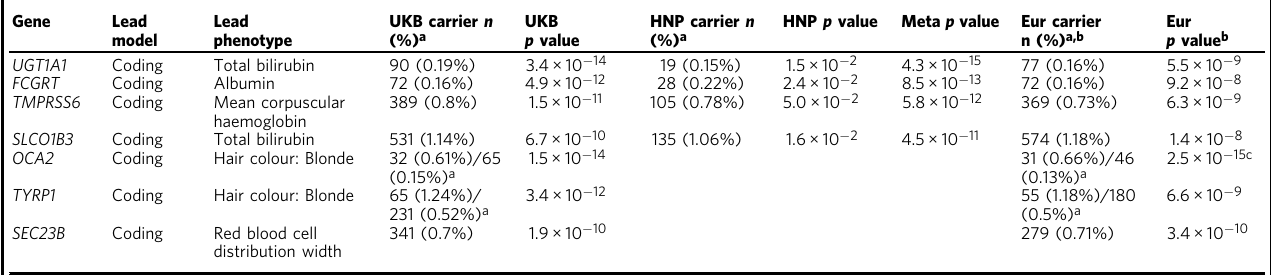
AllresultsshownarefromtheLMMwithallethnicities.Whenmultiplephenotypesand/ormodels(coding,LoF)weresigni fi cantlyassociatedwithagene,onlytheleadphenotypeandmodelareshown. All results can be found in Supplementary Data 2 a For binary traits, the information shown is case n (%)/ctrl n (%) b Eur carrier and Eur p value columns: For the phenotypes measured in both cohorts, the European meta-analysis values are shown. For the phenotypes measured only in UKB (blank for HNP), the UKB Eur values are